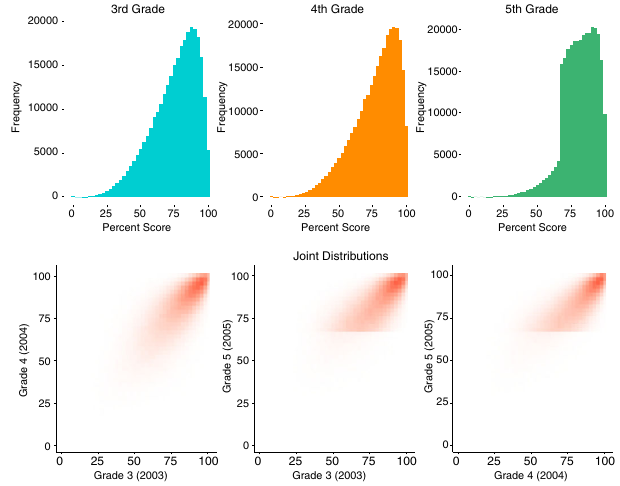
FIG. 8. Score distributions for TAKS mathematics exams in 3rd, 4th, and 5th grade, and correlations between students ’ scores for each grade pair. The score distributions for most of the exams are skewed as a result of the ceiling effects from the maximum score. The 5th grade and 8th grade exams have an additional floor effect due to the Student Success Initiative, discussed in Sec. VIII. The relationship between the scores for most exams is roughly